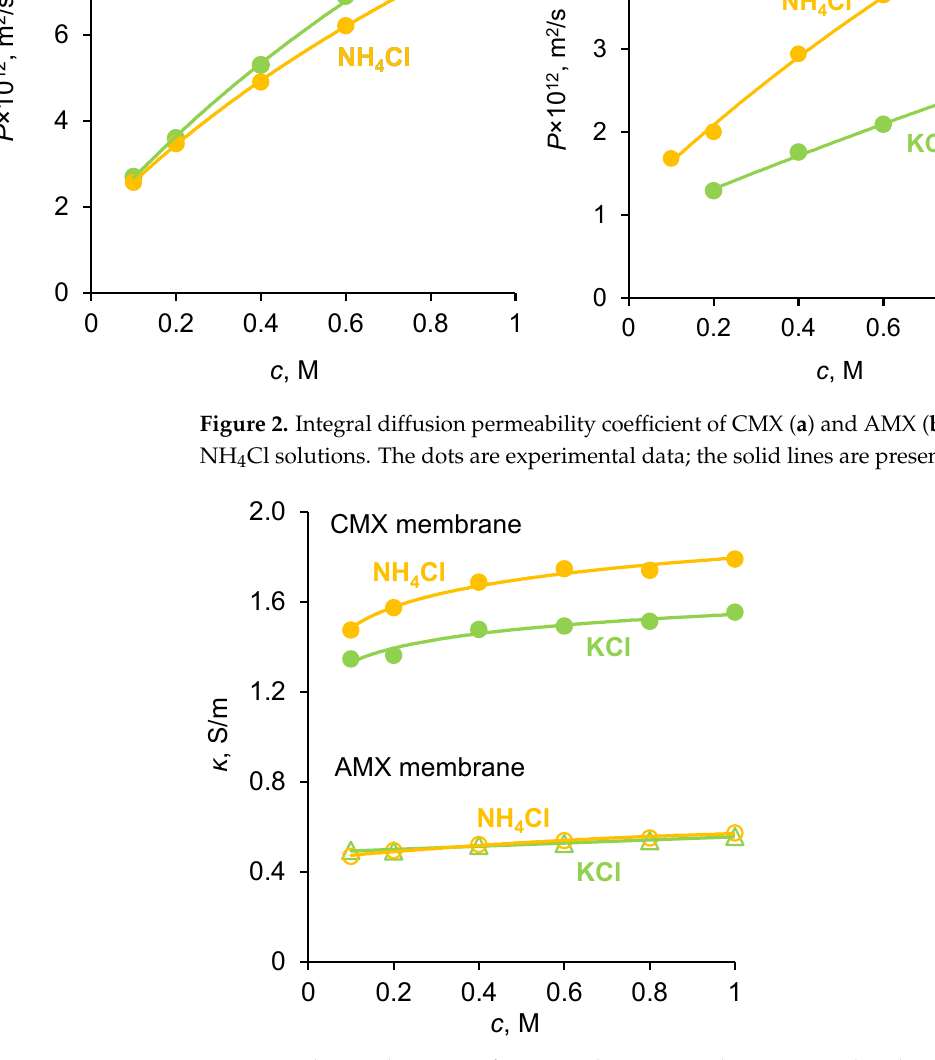
Figure 3. The conductivity of CMX and AMX membranes in KCl and NH 4 Cl solutions. The dots correspond to the experimental data; the solid lines are presented to lead the eye.